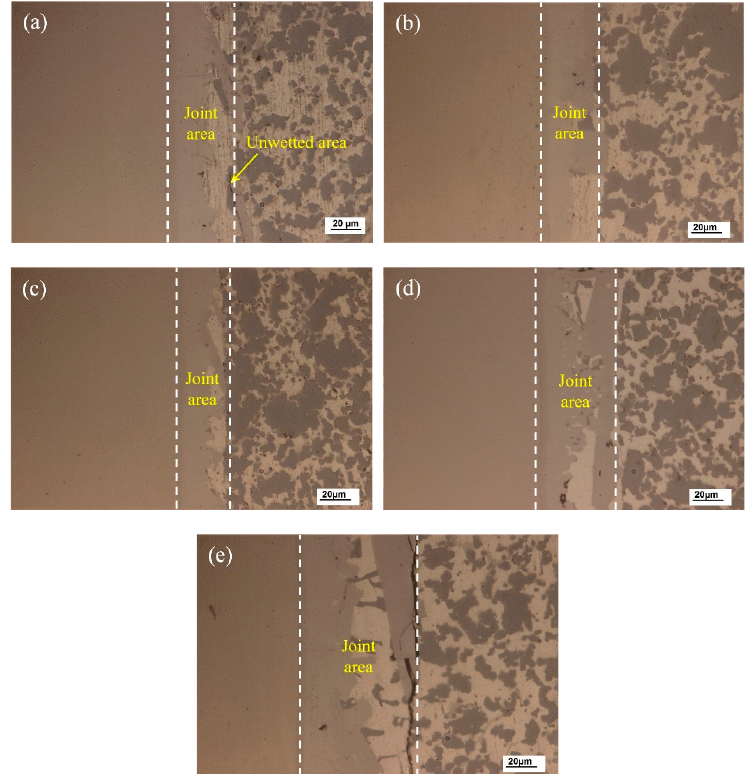
Figure 6. Optical micrographs of the joint made using different brazing temperatures: ( a ) 560 °C; ( b ) 570 °C; ( c ) 580 °C; ( d ) 590 °C; ( e ) 600 °C.